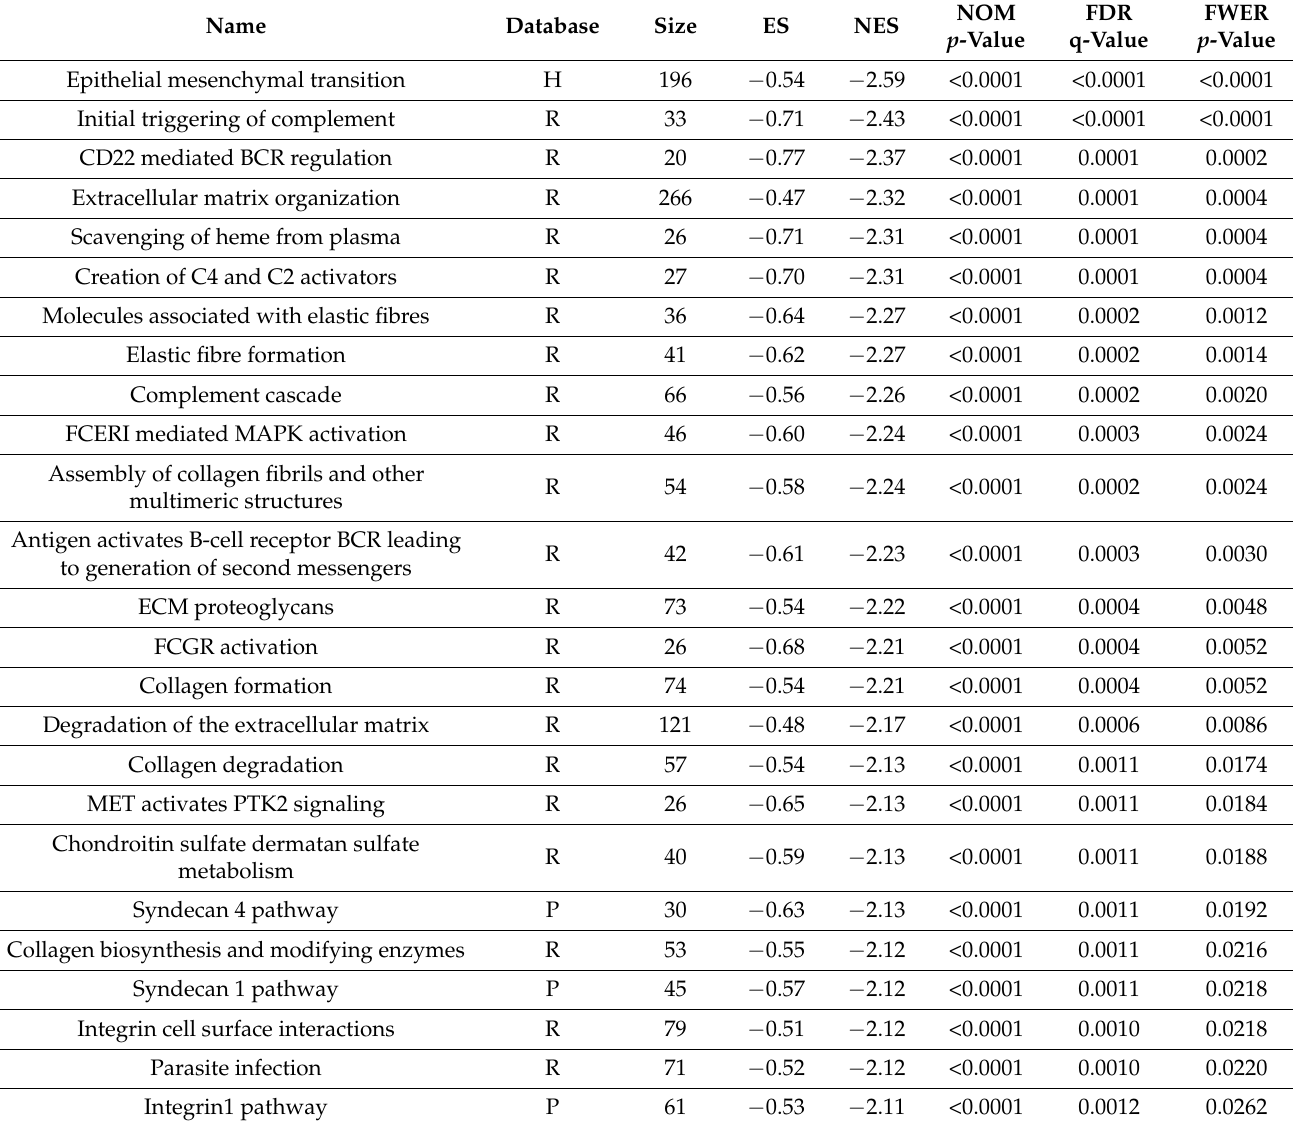
Table 3. Upregulated gene sets in SAT of patients with T2D analysed with